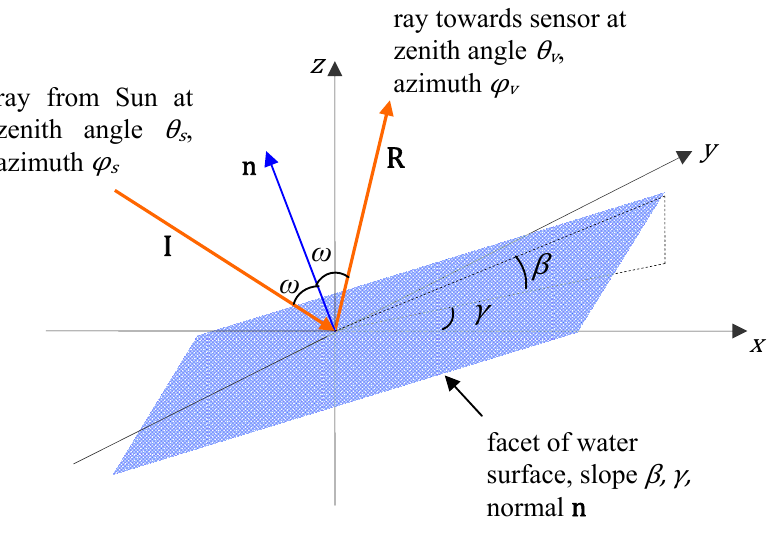
Figure 3. Sun glint geometry. Light from the sun, travelling along vector I , is reflected by the water surface to the satellite in the direction R . The normal to the water surface is n . x, y and z form a right-handed axis system, with the z -axis vertically upwards from the mean position of the sea surface. The choice of x -direction is arbitrary — in this paper x is taken as downwind. Zenith angles are measured from the z -axis, azimuth angles clockwise from the x -axis in the x‐y plane. The steepest slope of the water surface facet is β , at azimuth γ